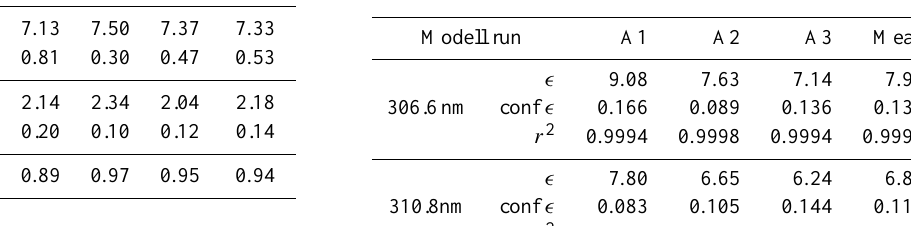
Table 4. Results from the fits of function (2) to approaches III–V. Approach